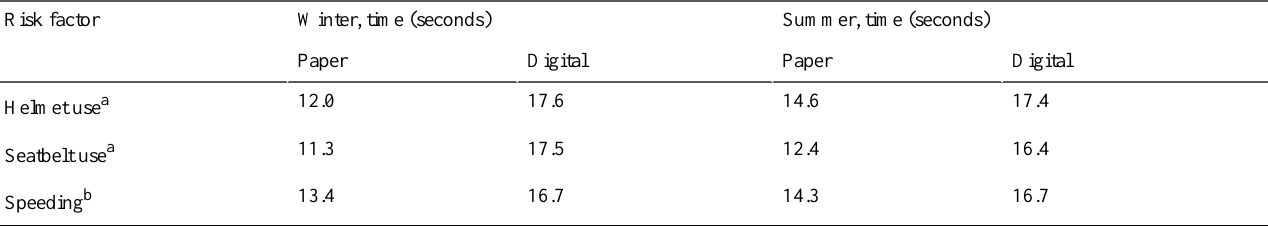
Table 6. Time in seconds to complete an observation by data collection method and